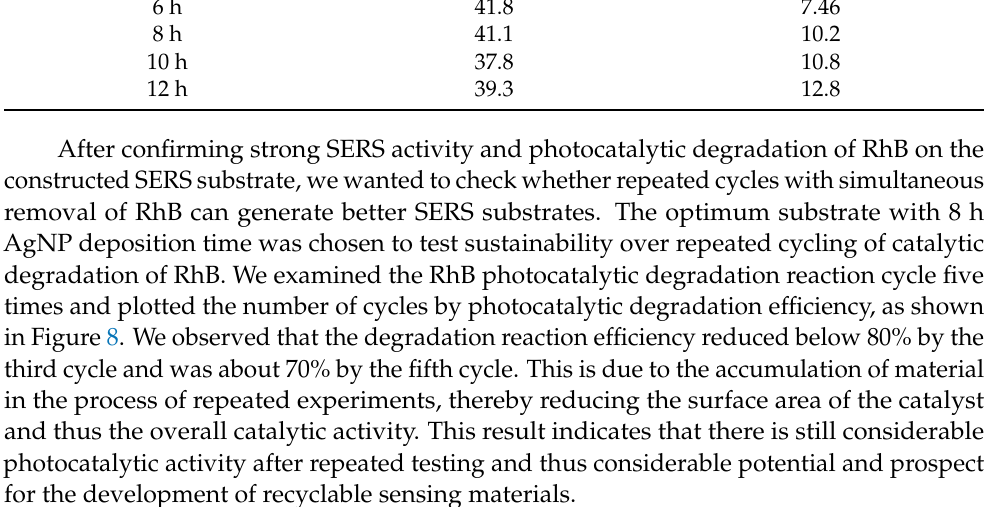
Table 2. ICP ‐ MS of substrates with different silver ‐ nanoparticle deposition times.